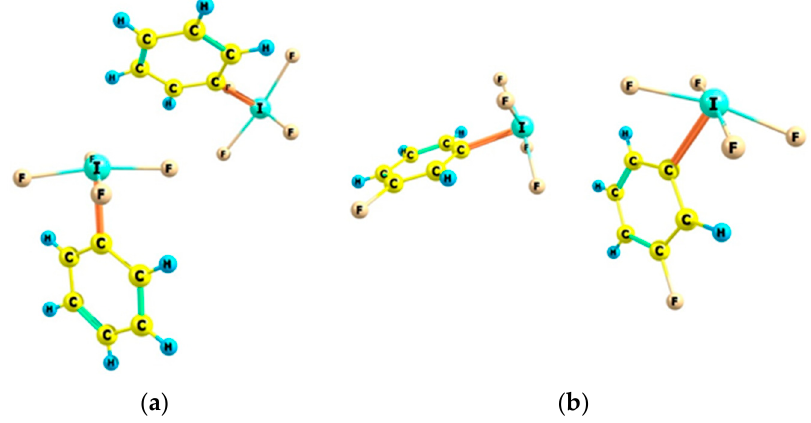
Figure 5. Two fragments of the crystal structures; ( a ) NACSQA refcode; ( b ) OJEDUE refcode. Supplementary Materials: Supplementary materials are available online.